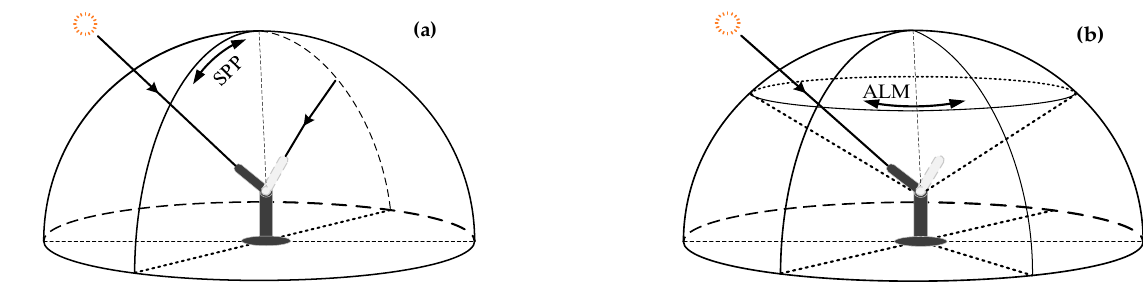
Figure 7. Diffuse-sky observation diagram of spectroradiometer: ( a ) SPP; ( b ) ALM. The control algorithm flow of the spectroradiometer is illustrated in Figure 8.